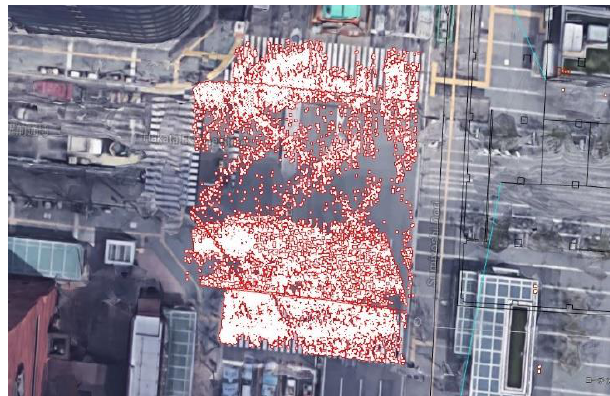
Figure 6. Spatial map employing GIS illustrations of the area of study; pedestrian movement detected by the camera is shown as points of data that have been transformed from the human detection system (HOG).